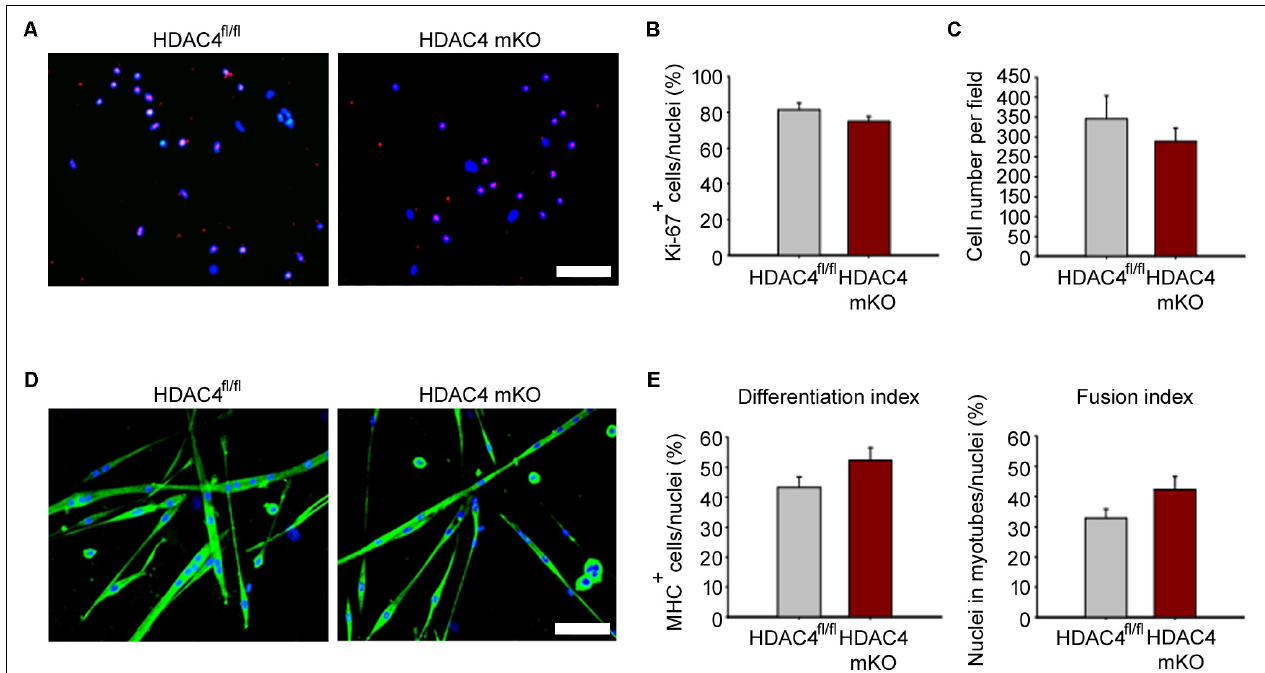
FIGURE 4 | HDAC4 mKO MDCs efficiently proliferate and differentiate in vitro . (A) Representative pictures of immunofluorescence for Ki-67 in HDAC4 mKO and HDAC4 fl/fl MDCs, after 24 h in growth media. Scale bar = 50 µ m. (B) Quantification of the proliferating Ki-67 + cells, over the total cell number. Data are presented as mean +/– SEM. n = 3 mice for genotype. (C) Quantification of HDAC4 mKO and HDAC4 fl/fl MDC number, after 24 h in growth media. Data are presented as mean +/– SEM. n = 3 mice for genotype. (D) Representative pictures of immunofluorescence for MHC in HDAC4 mKO and HDAC4 fl/fl MDCs, after 3 days in differentiation medium. Scale bar = 50 µ m. (E) Quantification of the differentiation and fusion indexes of HDAC4 mKO and HDAC4 fl/fl MDCs. Data are presented as mean +/– SEM. n = 3 mice for